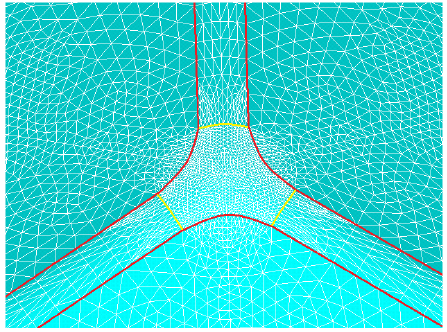
Figure 3. Mesh of the tip of the indenter with the bluntness 200 nm (case B, red line shows the border of the blunted area, yellow the border between the blunted tip and the